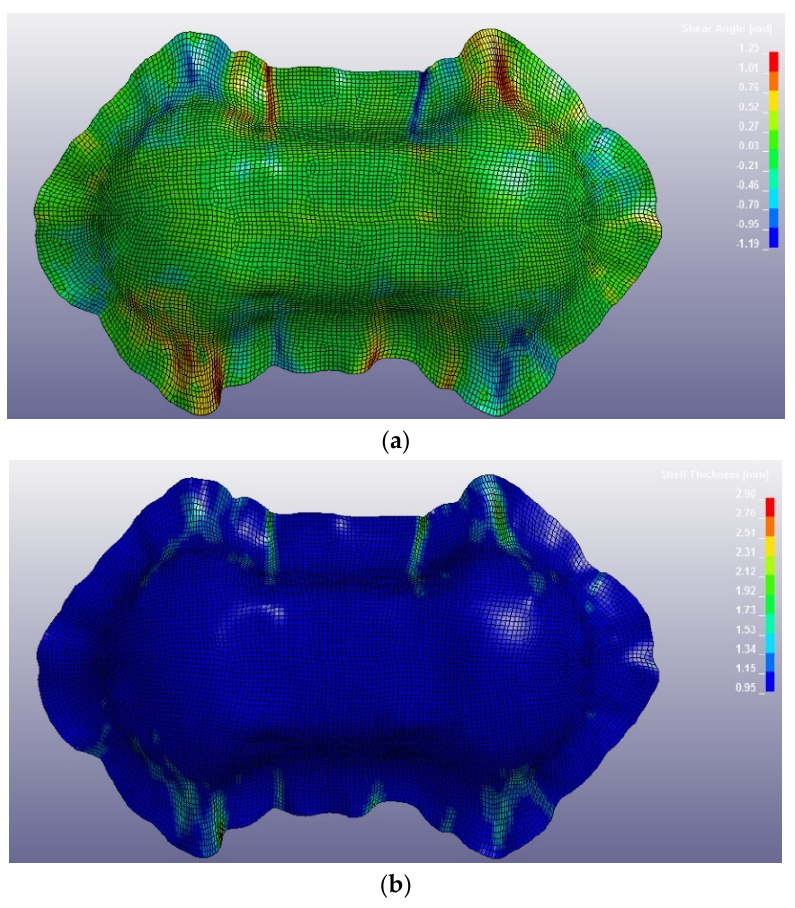
Figure 30. CF/EP-Angeloni and CF/EP-Solvay Double Dome after thermoforming simulation: values of shear angle ( a ) and values of shell thickness ( b ).